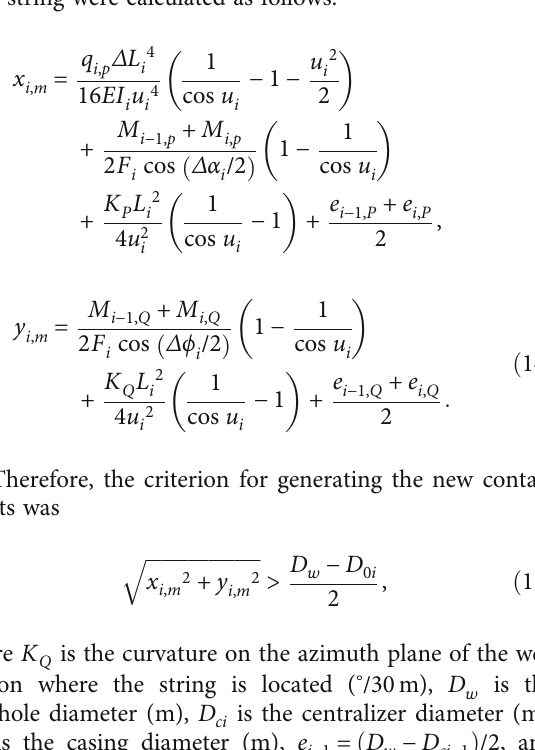
Figure 5: Finite element model of the casing string. Table 2: Basic calculation